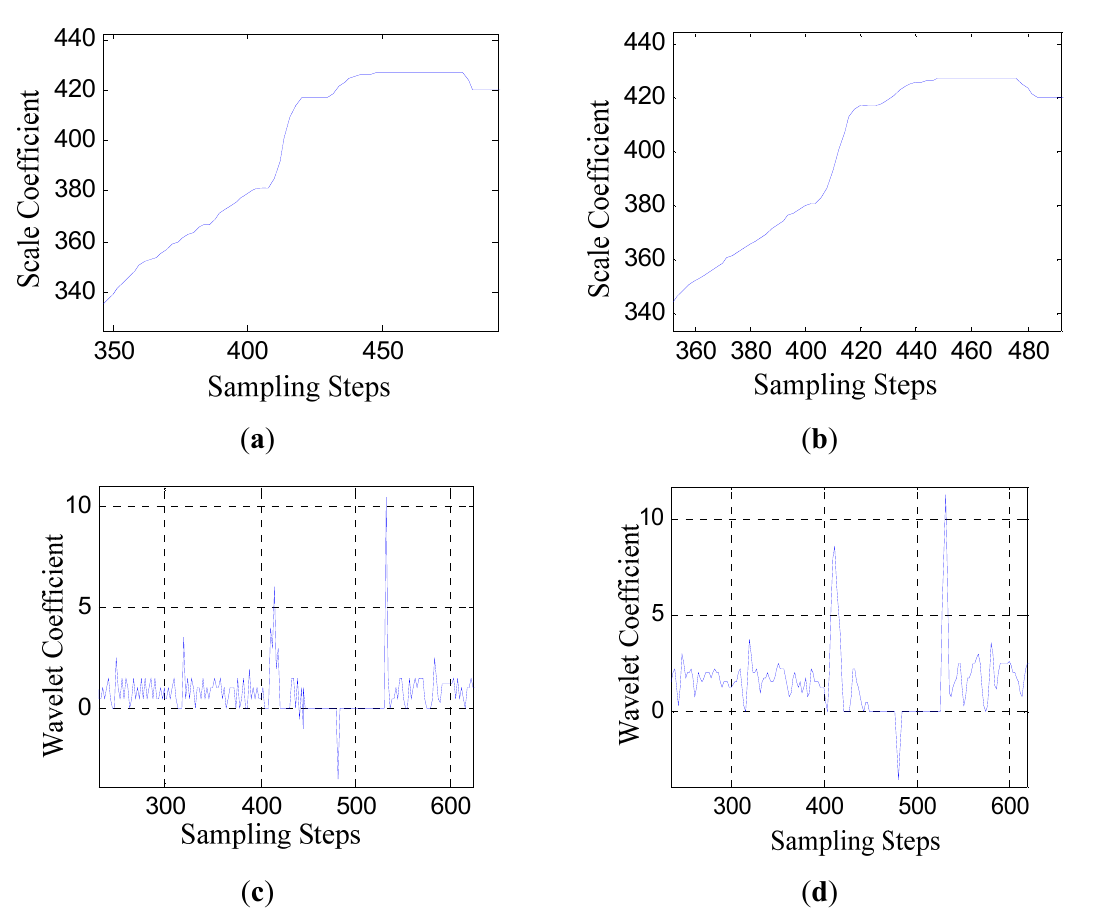
Figure 7. ( a ) The scale coefficients on the scale j = 1; ( b ) The scale coefficients on the scale j = 2; ( c ) The wavelet coefficients on the scale j = 1; ( d ) The wavelet coefficients on the scale j = 2.